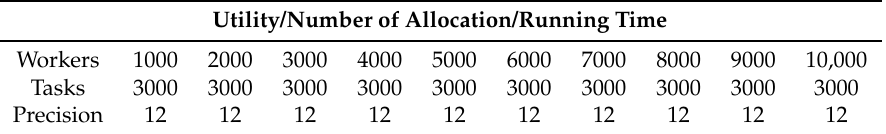
Table 5. Experimental settings for effect of large-scale